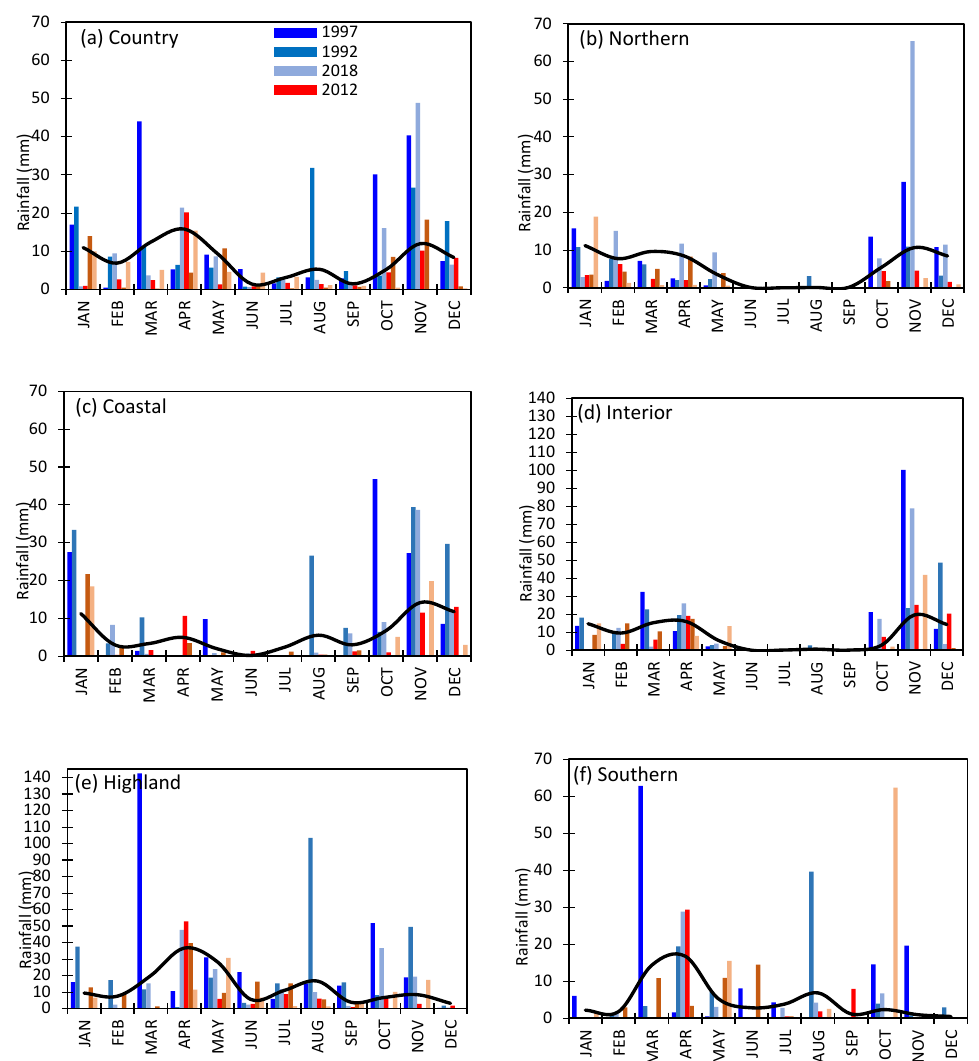
Figure 5. Annual cycle of rainfall (mm month − 1 ) for the ( a ) country, ( b ) northern, ( c ) coastal, ( d ) interior, ( e ) highland, and ( f ) southern regions for wet (1992, 1997, and 2018) and dry (2007, 2008, and 2012) years along with the rainfall climatology (mm, black solid curve) averaged for the period 1978–2019. The vertical axis scales are not the same for all panels.